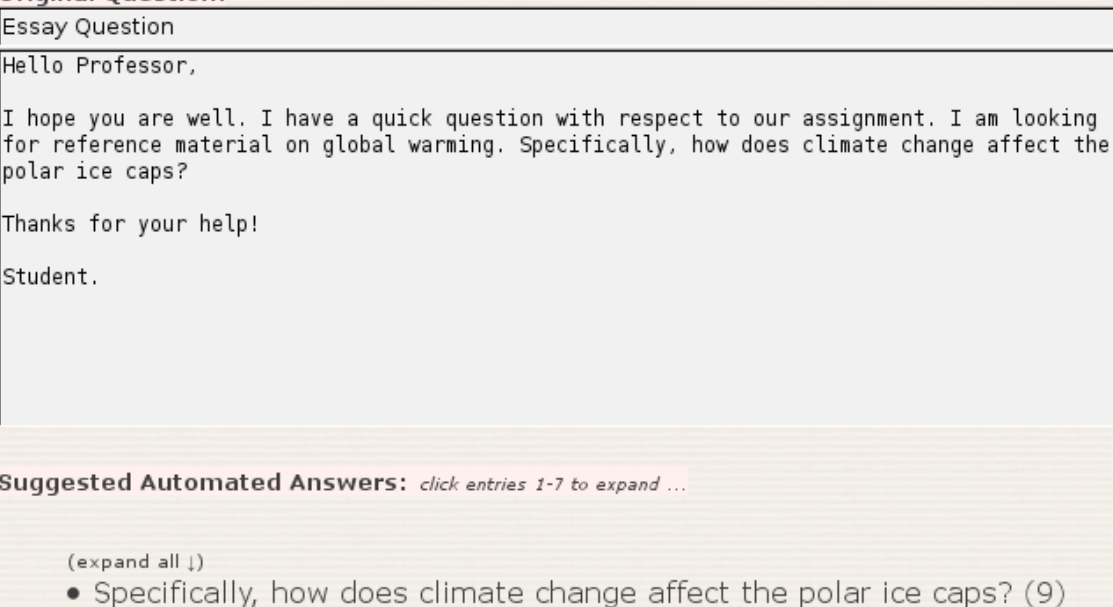
Figure 6 . Suggested second answer from the list of